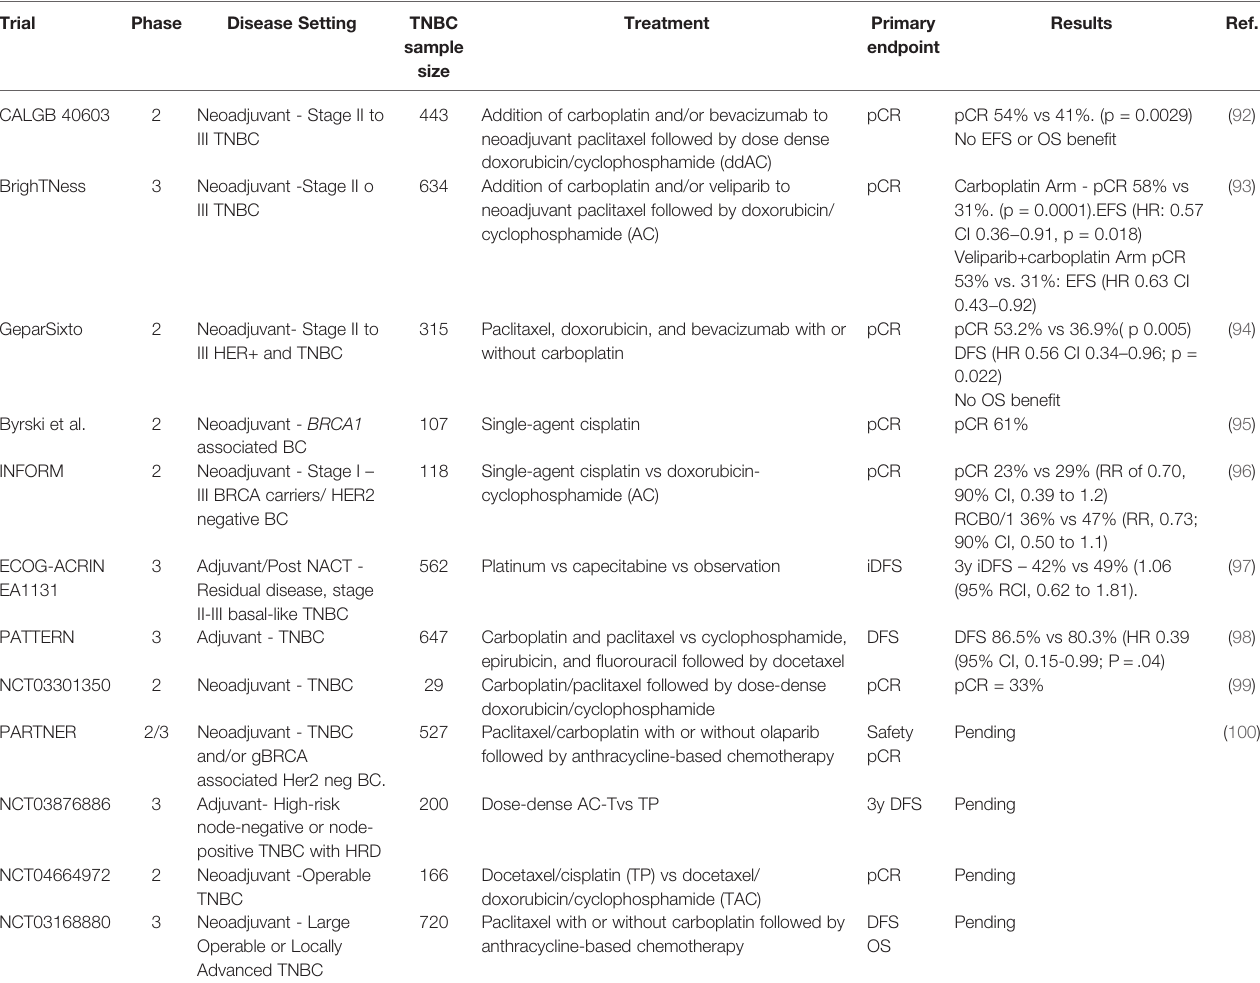
TABLE 6 | Major clinical trials involving platinum agents in patients with stage I – III